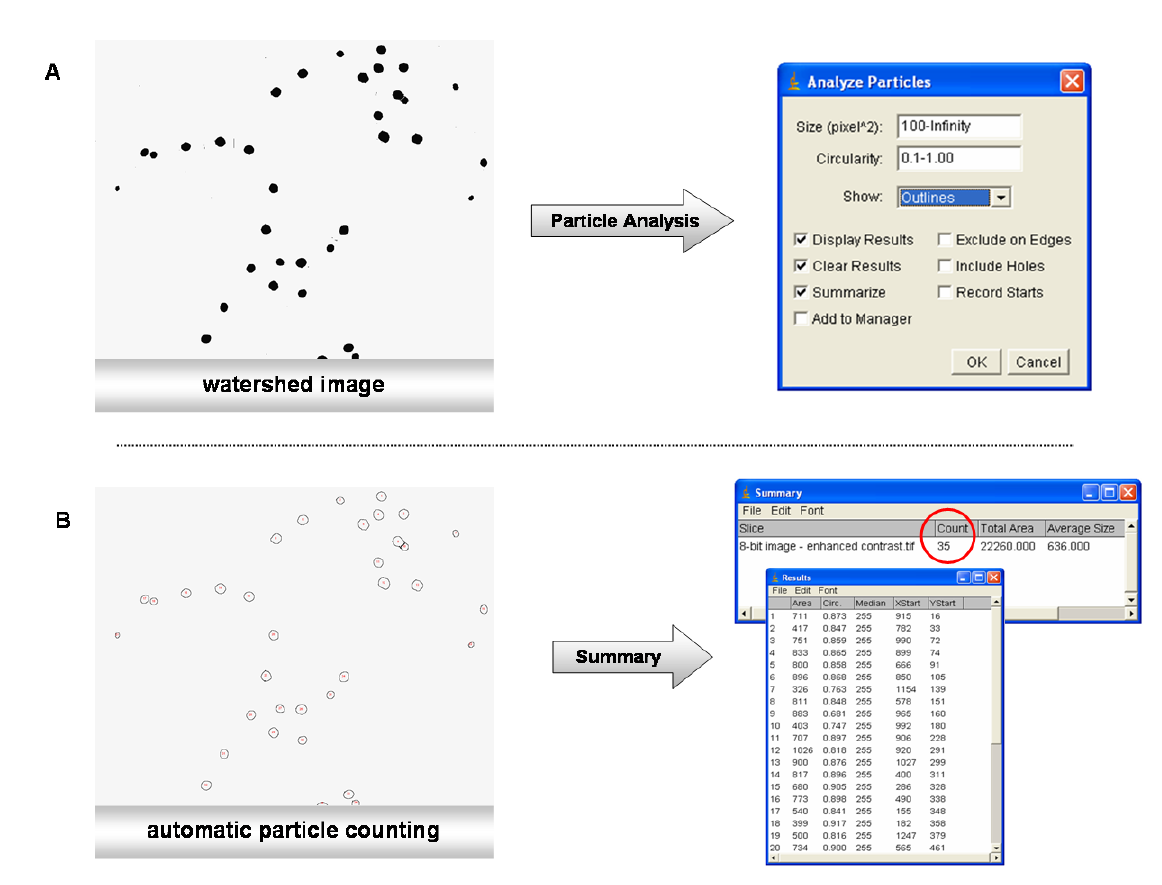
Figure 4b. Automatic nucleus-counting with ImageJ. A ) Particle analysis; B ) Automatic particle-counting based on the data generated by the watershed